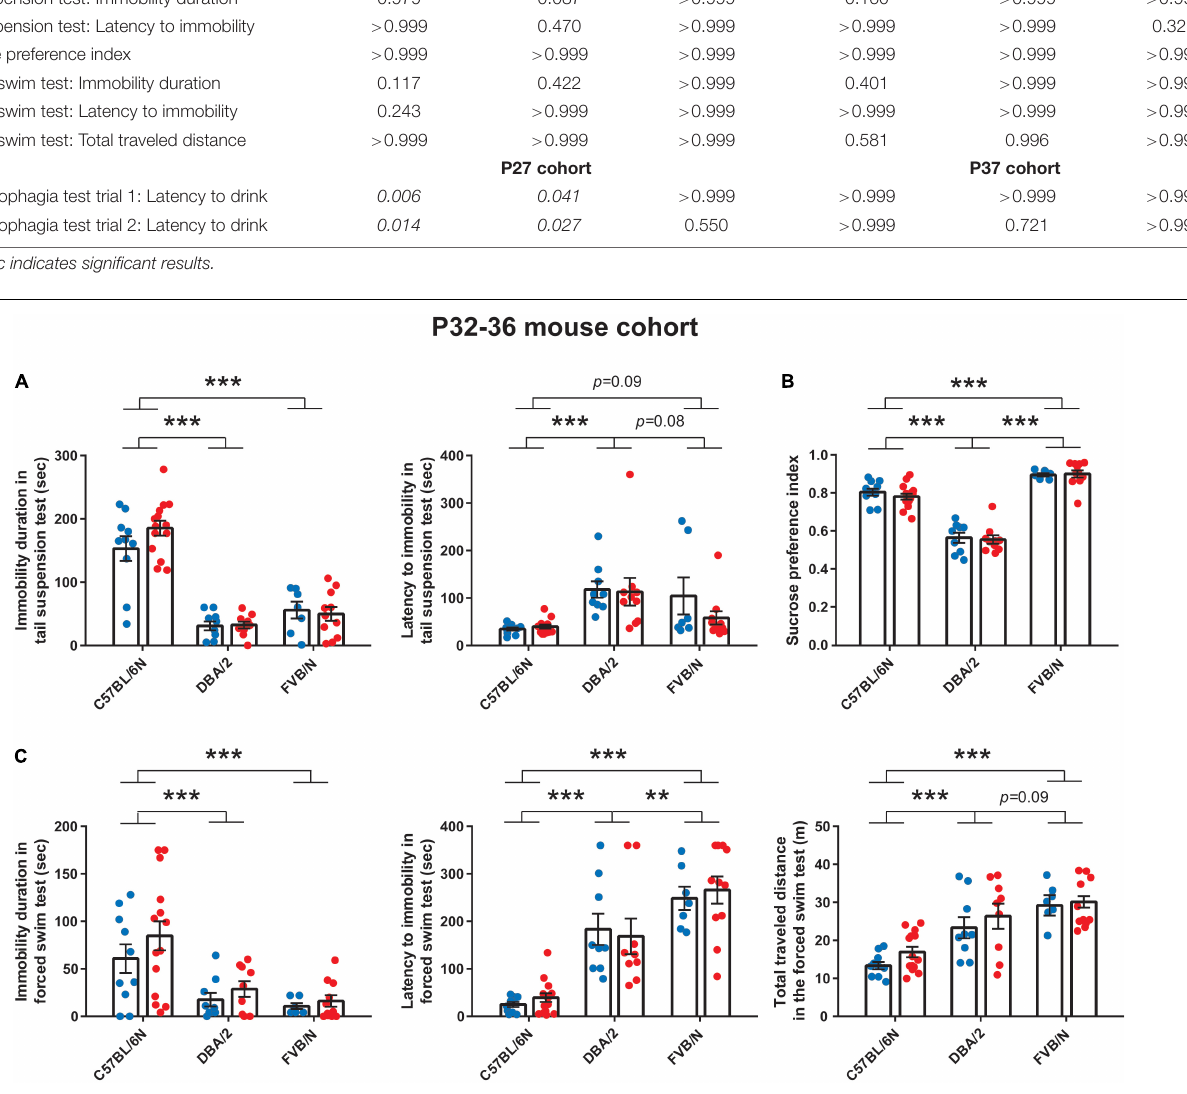
FIGURE 2 | Baseline depression-like behaviors in P32–36 mouse cohort. (A) In the tail suspension test, C57BL/6N mice showed a significant increase in the baseline immobility duration compared to both DBA/2 and FVB/N mice. C57BL/6N mice showed a significantly decreased latency to first immobility compared to DBA/2 and borderline decreased latency compared to FVB/N mice. (B) In the sucrose preference test, DBA/2 mice showed an increased baseline anhedonia-like behaviors by having a significantly decreased sucrose preference index compared to both C57BL/6N and FVB/N mice. Moreover, FVB/N mice showed an increased sucrose preference index compared to C57BL/6N mice. (C) In the forced swim test, C57BL/6N mice showed an increased immobility duration, a decreased latency to first immobility and a decreased total traveled distance compared to both DBA/2 and FVB/N mice. In (A–C) , no sex difference was revealed within any of the aforementioned strains. Blue and red dots represent males and females, respectively. Two-way ANOVA followed by Tukey post hoc test, ** p ≤ 0.01, *** p ≤ 0.001. Error bars indicate the standard error of the mean